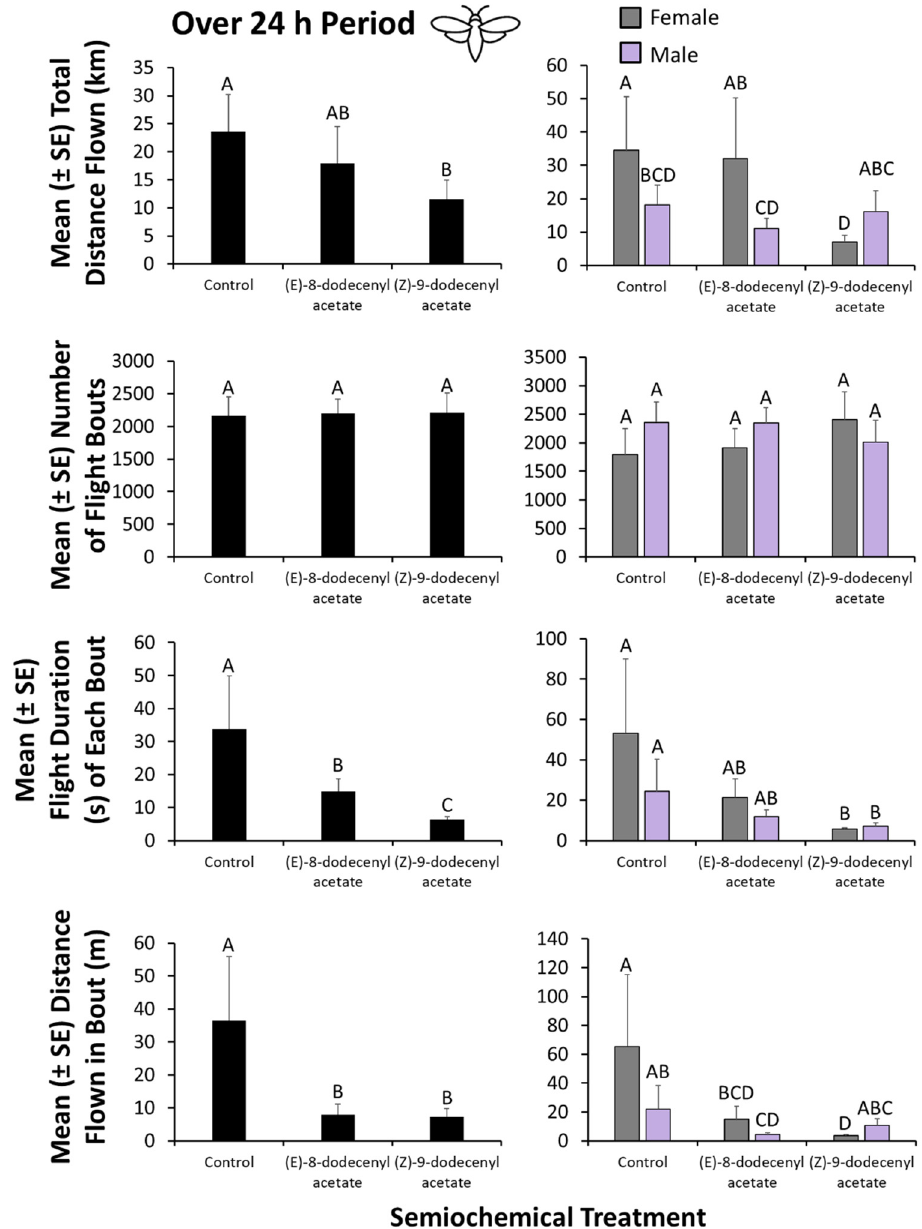
Figure 4. Characterization of flight behavior of E. giganteana on computer-automated flight mills in the laboratory over a 24-h period to evaluate the individual and combined effect of the presence of ( E )-8-dodecenyl acetate and ( Z )-9-dodecenyl acetate from the field baiting experiment above, as well as the sex (female—grey bars, male—purple bars) of an individual on flight capacity. A total of n = 18 replicate moths were tested per semiochemical treatment. Bars with shared letters are not significantly different from each other (Tukey HSD, α = 0.05).